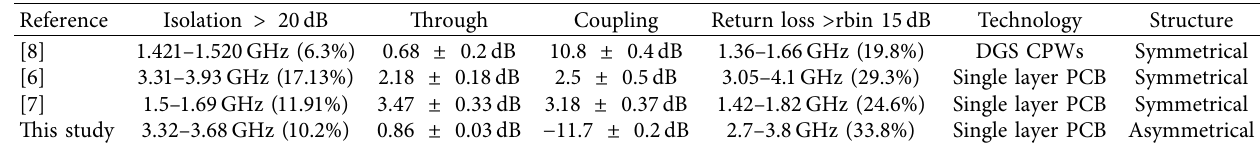
Table 10: Compression between TRD coupler in other papers and this study 10dB ATRD coupler.